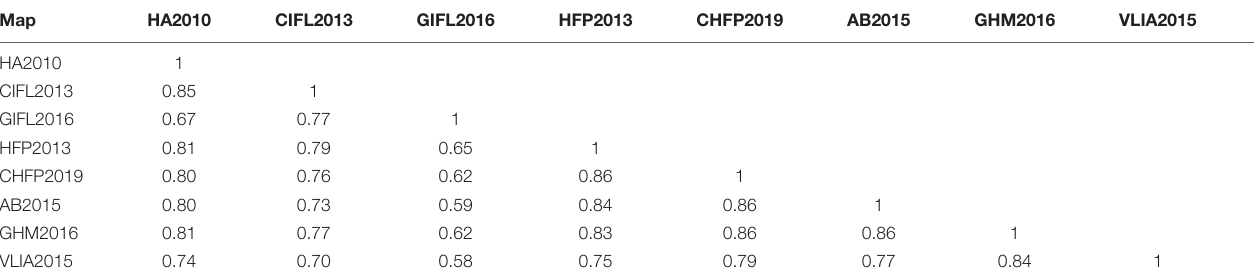
TABLE 4 | Proportional agreement between each pair-wise map comparisons within Canada’s boreal region measured using Jaccard’s similarity